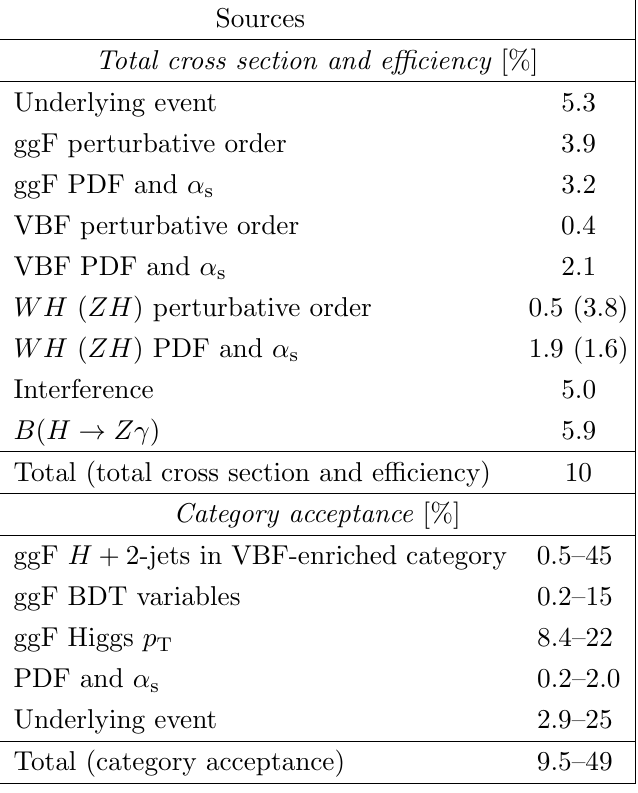
Table 5 . The main sources of theoretical and modelling uncertainties for the H ! Z(cid:13) search. For the uncertainties in the total e(cid:14)ciency and the acceptance of the di(cid:11)erent categories, the gluon- gluon fusion samples produced with Powheg Box v1 with and without MPI are used, as well as the nominal Powheg Box v2 gluon-gluon fusion signal sample along with the sample generated with MadGraph5 aMC@NLO , as described in the text. The combined uncertainty on the total cross section and e(cid:14)ciency is given assuming the cross sections predicted by the SM. The ranges for the uncertainties cover the variations among di(cid:11)erent categories. The uncertainty values are given as relative